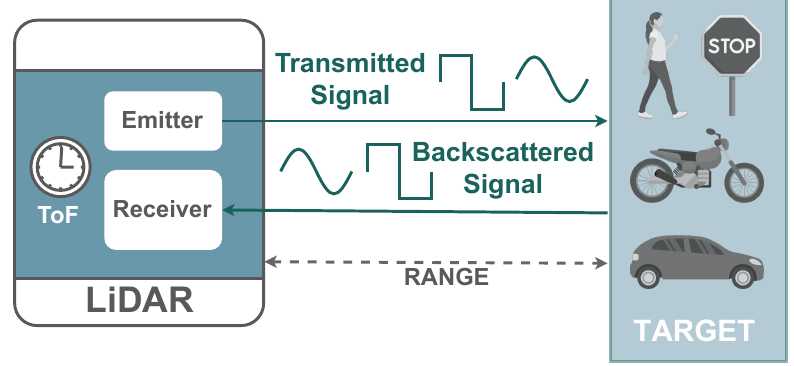
Figure 2. LiDAR working